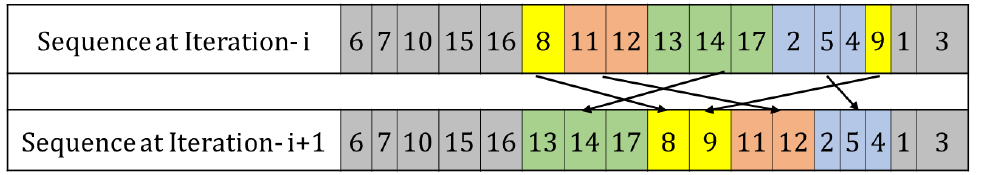
Figure 4. Part/Subassembly position swapping in the assembly